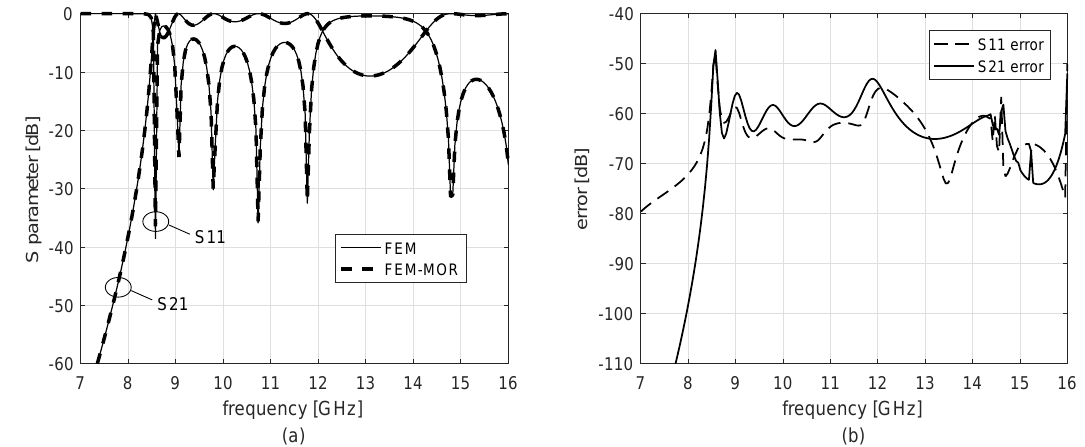
Figure 3. S-parameters ( a ); and MOR error S 11err and S 21err ( b ) of the structure in Figure 2 for M = 8 subdomains and macromodels, port size p 0 = 10 and reduction order q =